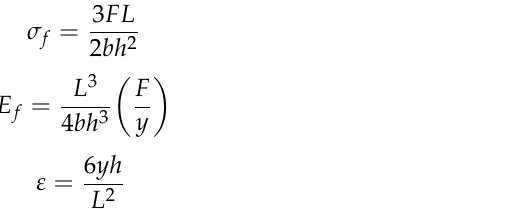
Table 3. Specimen dimensions . Specimen The maximum flexural stress ( σ f ), flexural modulus ( E f ) and strain ( ε ) were calculated using Equations (1)–(3).